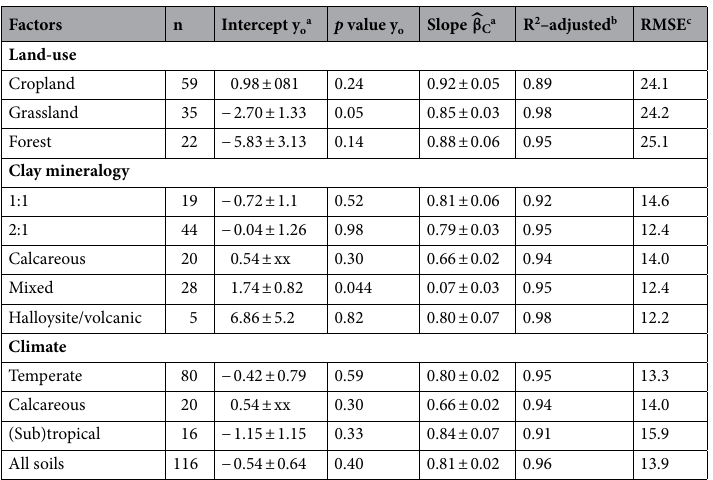
Table 5. Ordinary least squares linear regression between carbon in particles < 20 µm and organic carbon in the bulk soil of published results (± standard). See the references in Table 2. a y = y o + (cid:31) β C the slope and and ω is SOC content of bulk soil . The p values of in the size fraction < 63 µm